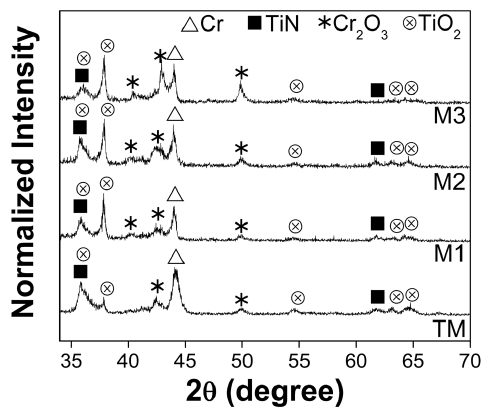
Figure 9. GAXRD patterns of coatings oxidized at